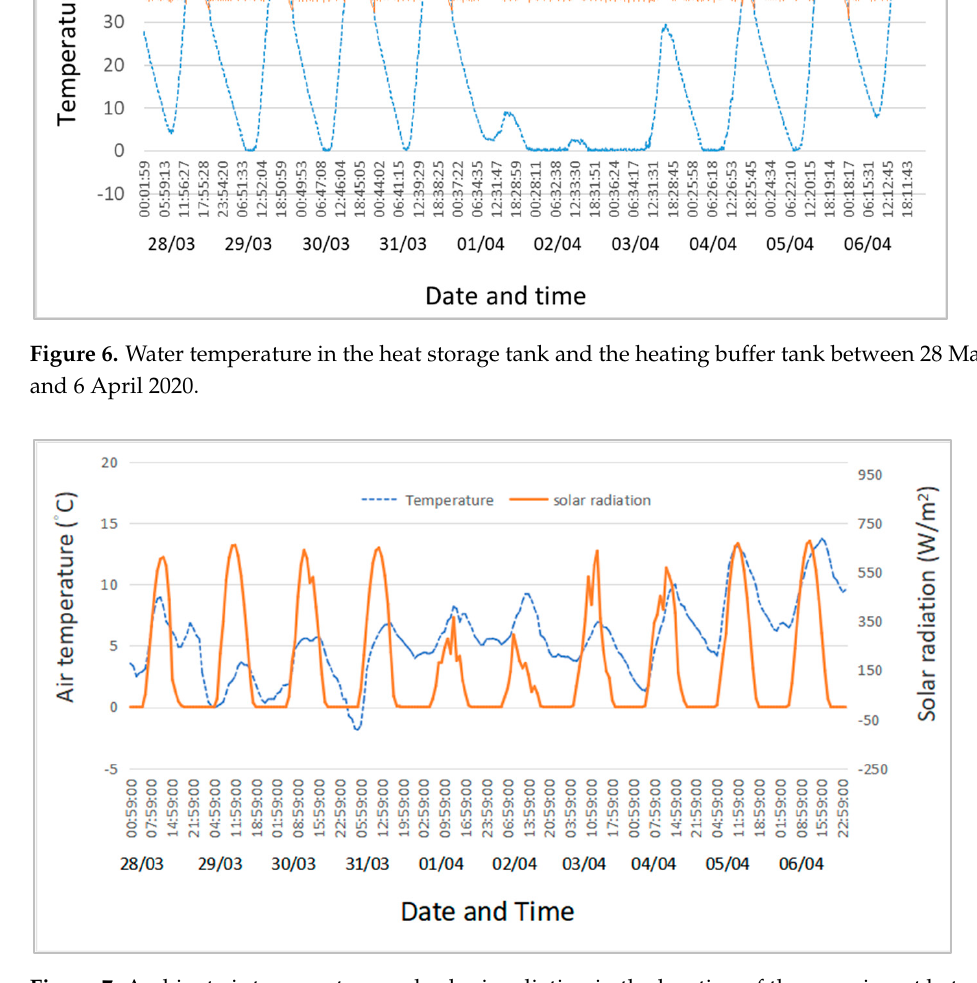
Figure 7. Ambient air temperature and solar irradiation in the location of the experiment